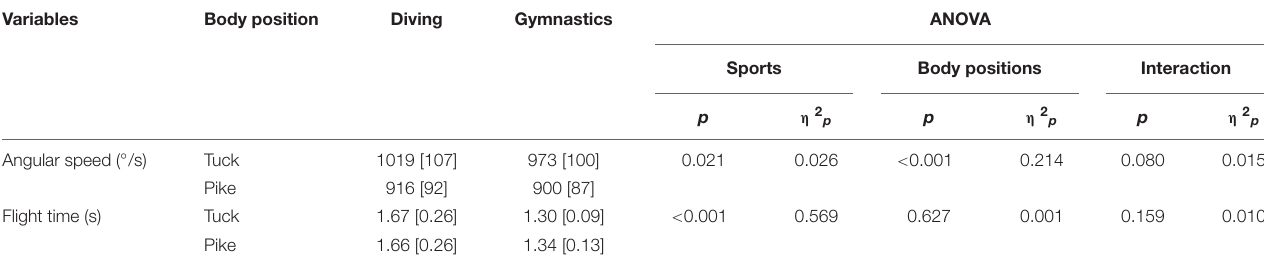
TABLE 2 | Comparison of angular speed and flight time by sports (diving/gymnastics) and body positions (tuck/pike). Variables